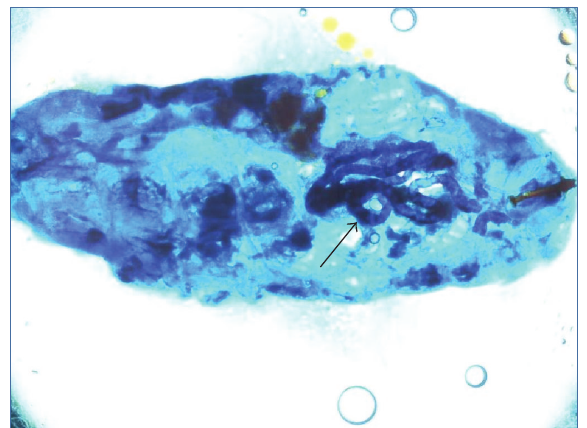
Figure 21: A prepupal third instar makes a cocoon with silk from the labial gland.